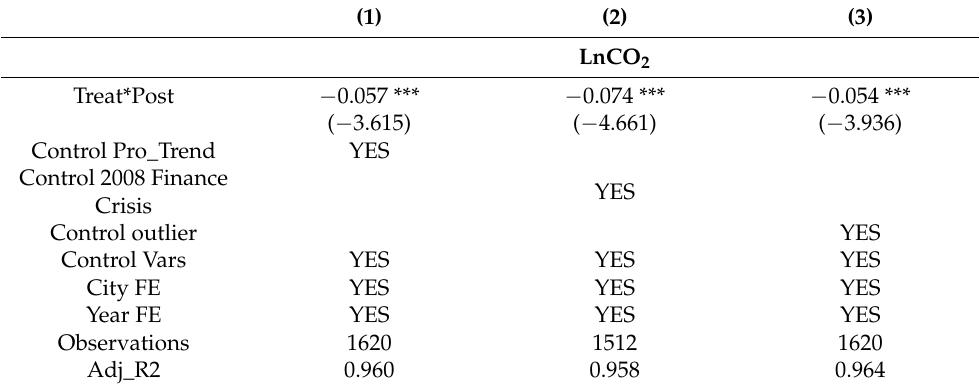
Table 5. Other robustness check of the effect of city cluster policy on CO 2